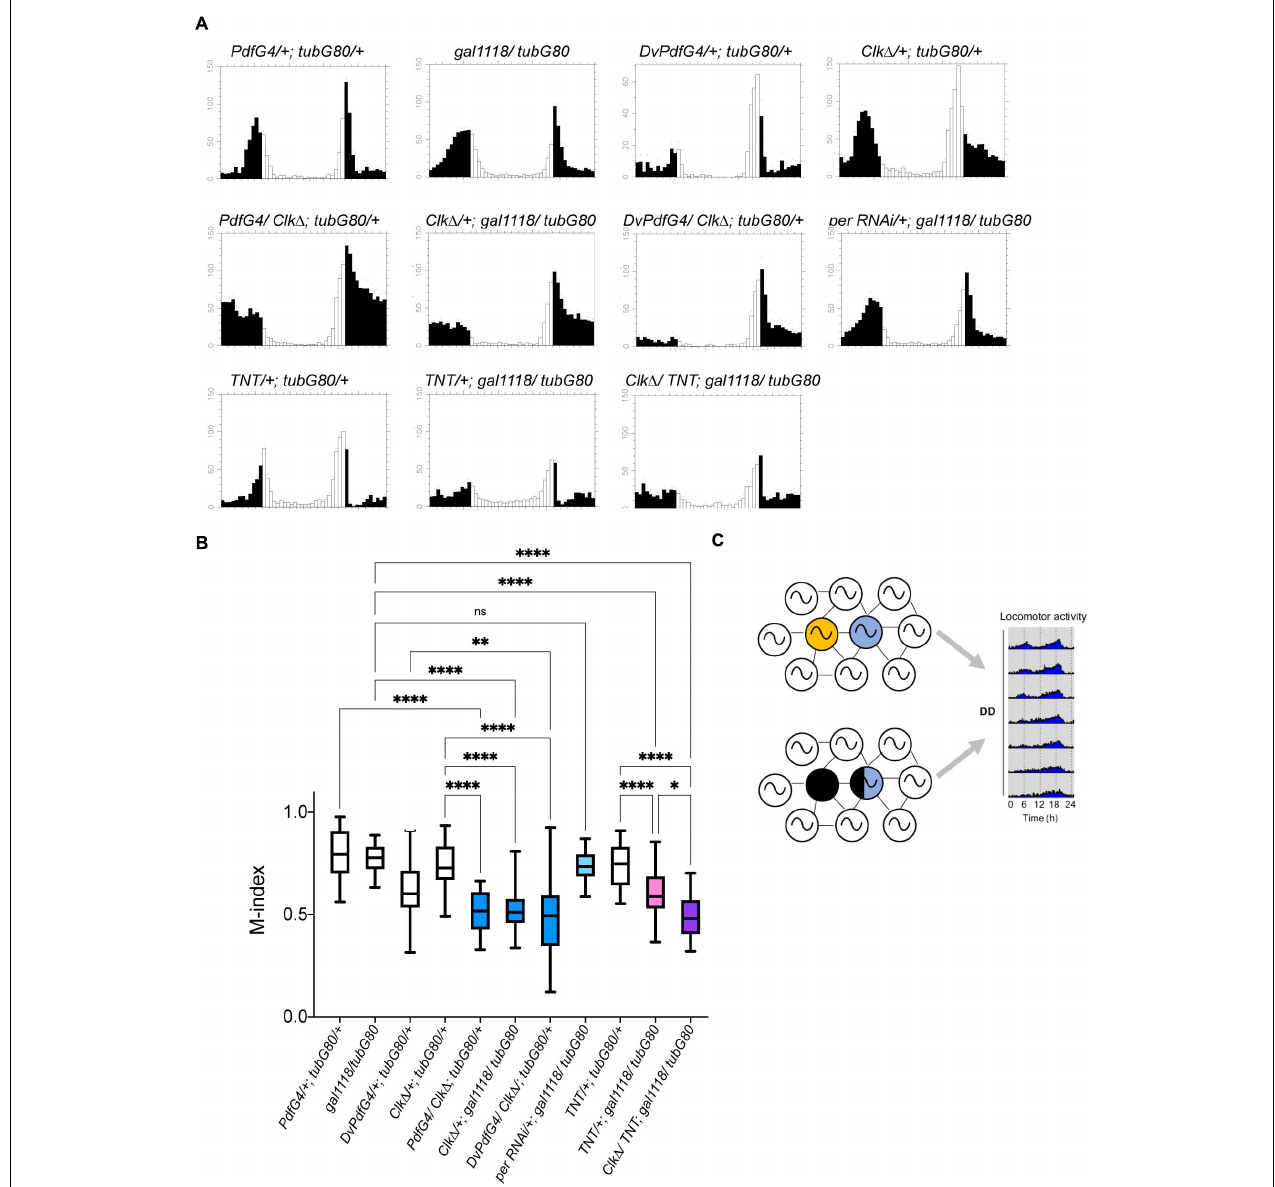
FIGURE 7 | LD-entrained activities of flies with the adult-restricted disruption of clocks or neural output of the M-cells. (A) Average activities of flies of the indicated genotypes in LD. White bars indicate activity levels during the light period and black bars represent the dark period. (B) M-indices of the flies of indicated genotypes. Whiskers indicate 5th and 95th percentile and the line inside the box indicates the median. ∗ p < 0.05, ∗∗ p < 0.01, ∗∗∗ p < 0.001, and ∗∗∗∗ p < 0.0001 by the Kruskal-Wallis test with Dunn’s multiple comparisons test. (C) A schematic summarizing the finding of this study. Circadian pacemaker network consists of diverse classes of clock-containing pacemaker neurons, including the M-oscillator (yellow) and the E-oscillator (blue). The traditional model postulates that the M-cells (yellow) drive free-running locomotor rhythms via synchronizing the pace of the E-cells. In this study, we show that locomotor rhythms can free-run several cycles while clocks in the M-cells and part of the E-cells are disrupted during adulthood, supporting the emerging view that the circadian circuit can flexibly assign different neuronal subgroups the pacemaking role to maintain rhythmic locomotor